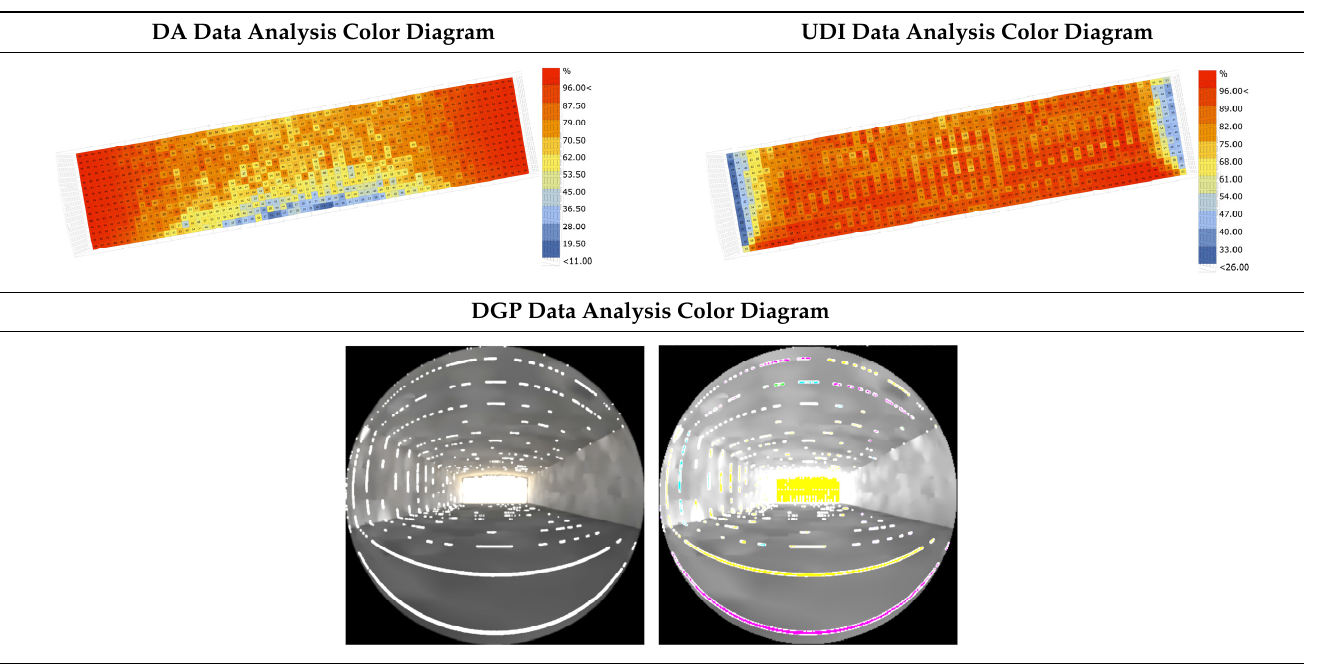
Table 5. Visual analysis of natural lighting performance.